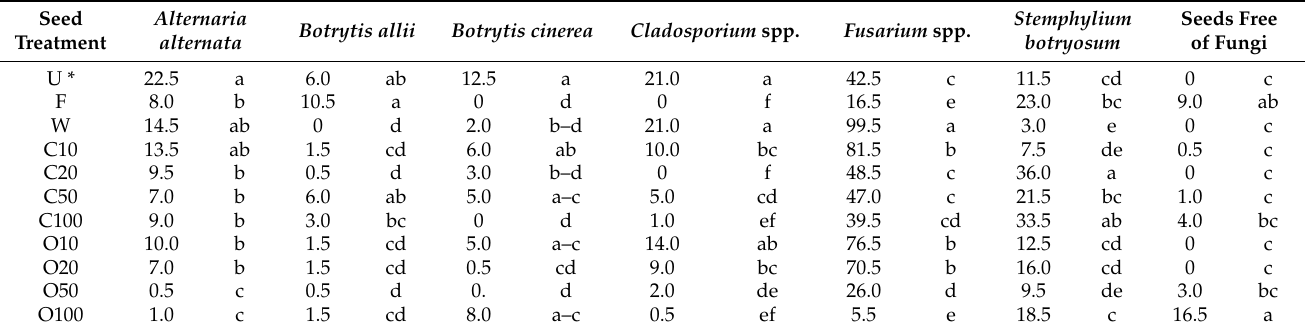
Table 6. Effects coconut and oregano hydrolates treatment on the incidence of fungi on onion seeds of sample II and seeds free of fungi